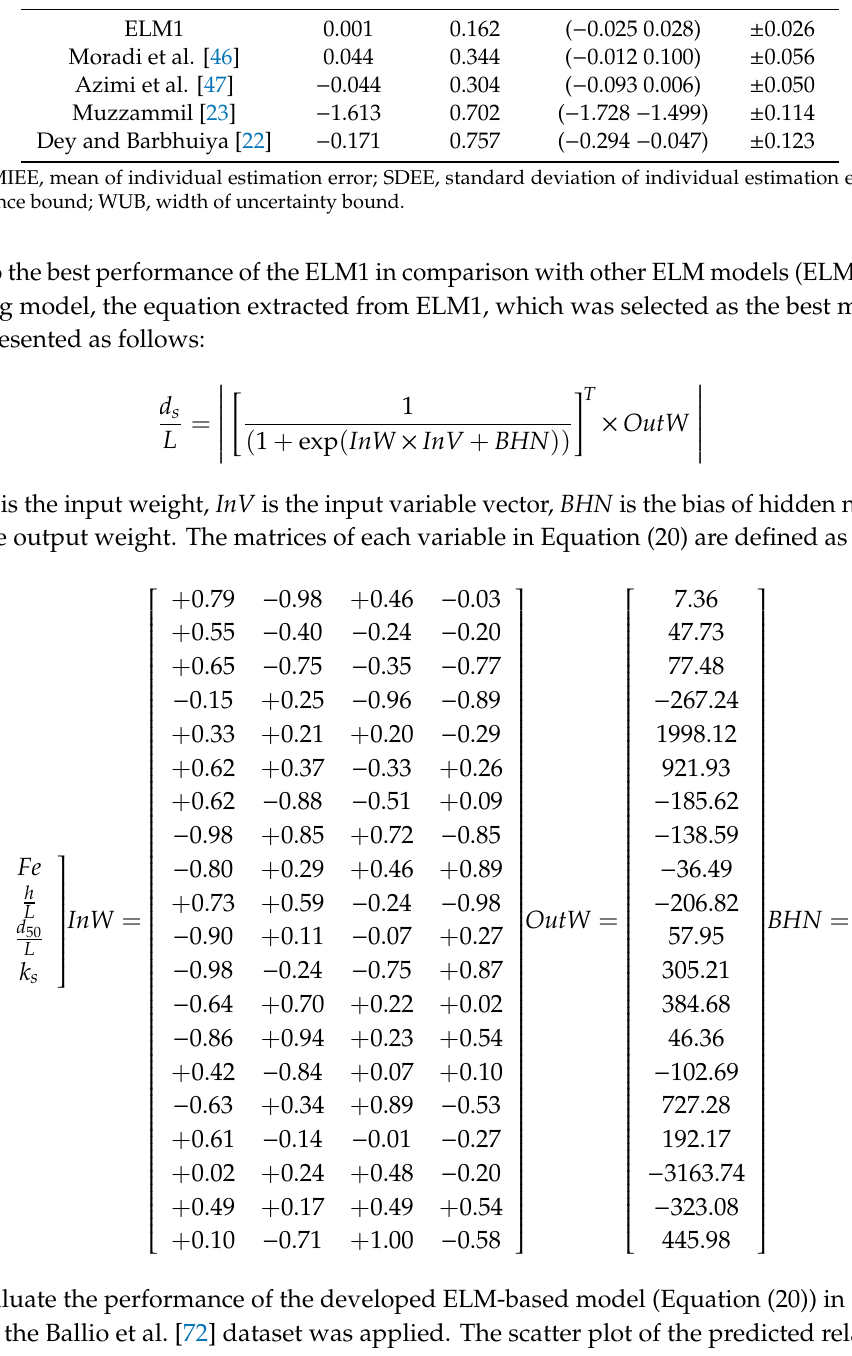
Table 3. Uncertainty analysis of the developed ELM model versus existing regression and artificial intelligence (AI)-based techniques. Model MIEE SDEE 95% CB WUB ELM1 0.001 0.162 ( − 0.025 0.028) ± 0.026 Moradi et al. [46] 0.044